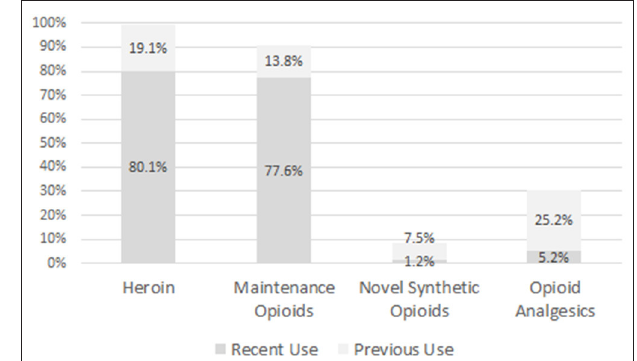
FIGURE 1 | Proportion of patients reporting recent (last 30 days before admission to detoxification treatment) or previous use of several classes of opioids.